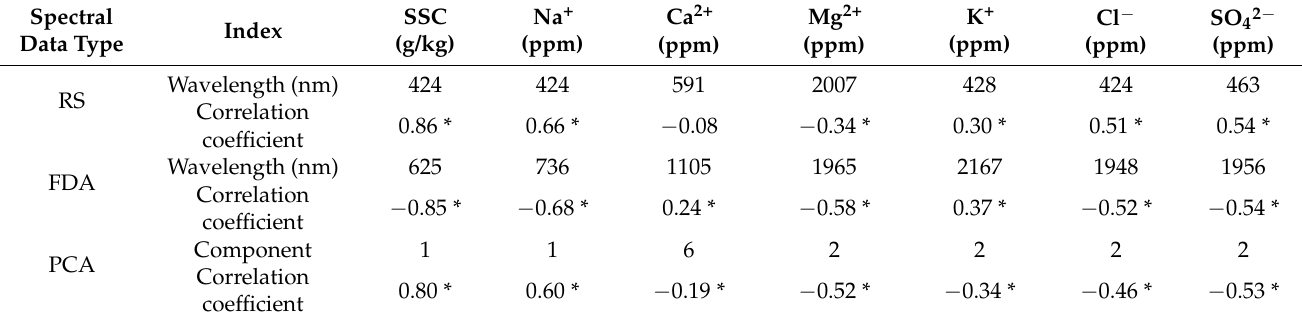
Table 2. Statistical table of the maximum correlation coefficient between the raw spectra (RS), first-derivative analysis (FDA), principal component analysis (PCA) and SSC, as well as Na + , Ca 2+ , Mg 2+ , K + , Cl − , and SO 42 − contents. Spectral Data